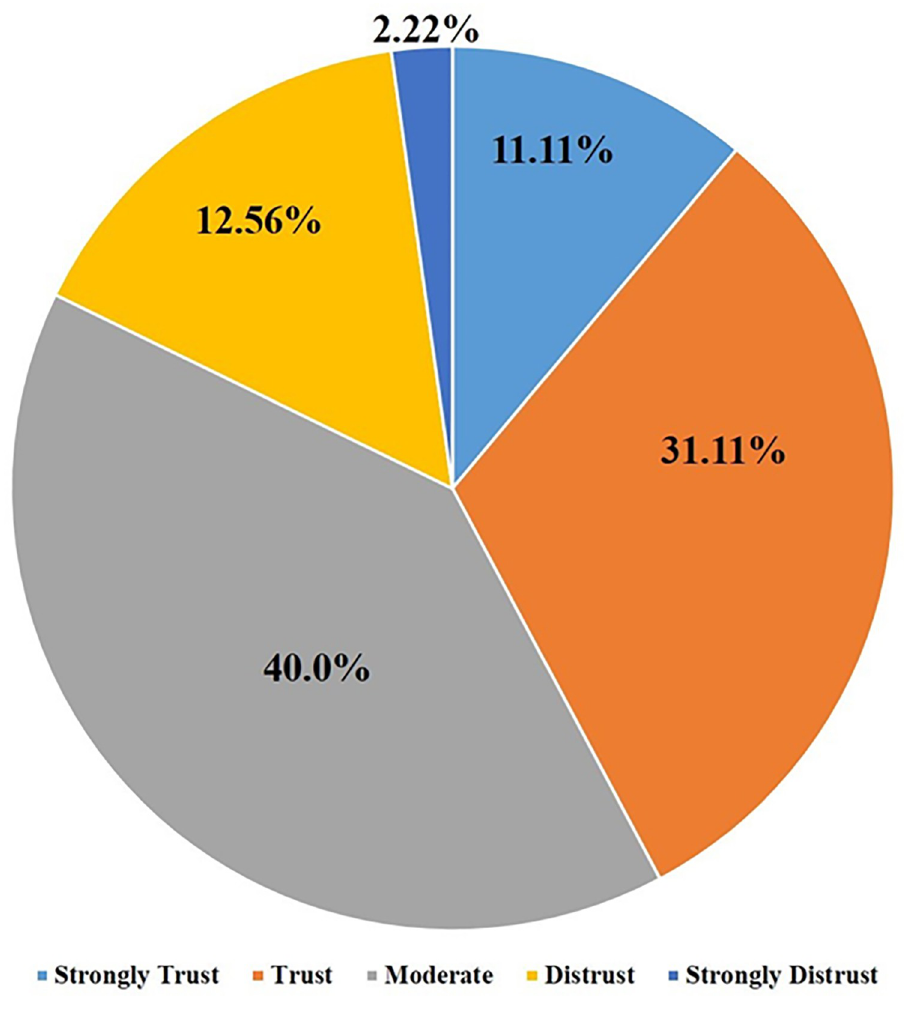
Fig 3. Reliability of using O‘view M to